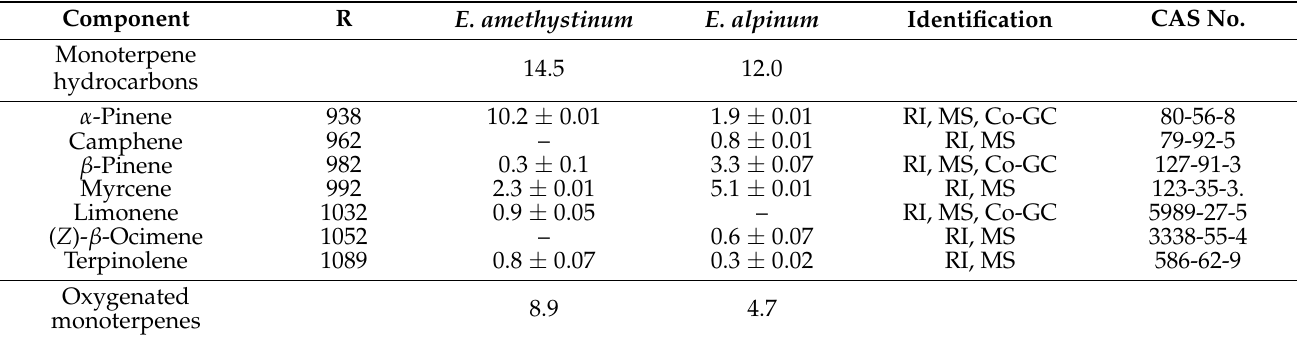
Table 1. Composition (expressed in %) of the essential oils of both E. amethystinum and E. alpinum . Component R E. amethystinum E. alpinum Identification CAS No.